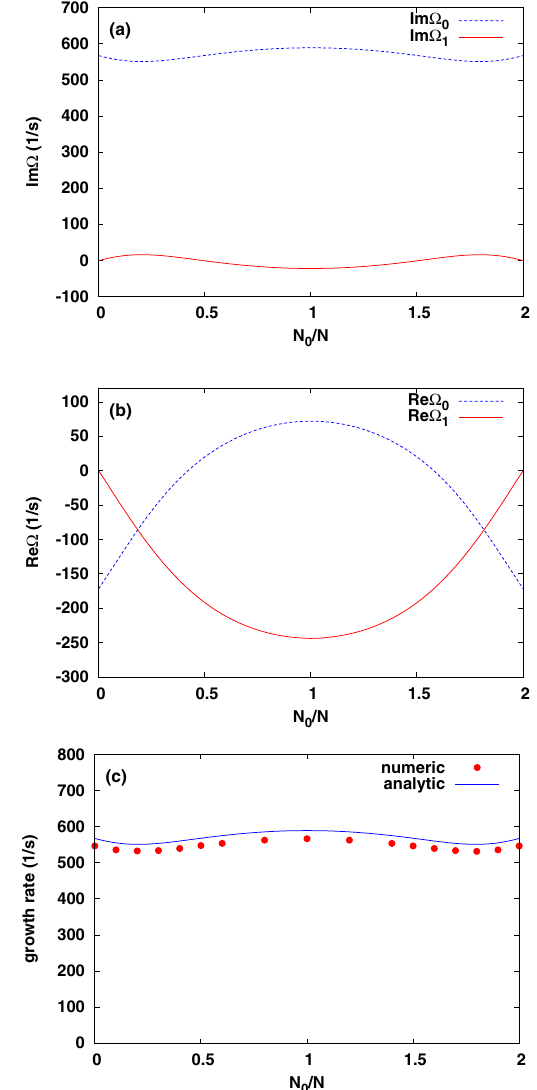
FIG. 3. (a) Imaginary part (growth rate) and (b) Real part (frequency shift) of the modes Ω 0 and Ω 1 , given by Eq. (73), for the case of two bunches ( M ¼ 2 ). N 0 and N 1 are the number of particles per bunch, and satisfy N 0 þ N 1 ¼ 2 N , where N is the number of particles per bunch in the uniform filling pattern case ( N 0 ¼ N 1 ¼ N ). For N 0 ¼ 0 and N 0 ¼ 2 the system of two bunches degenerates in the system describing one bunch with 2 N particles. The most unstable configuration is the configuration with the uniform filling pattern. (c) Comparison of the growth rates of mode 0 given by Eq. (73) as a function of N 0 =N with SPACE self-consistent simulations, showing close